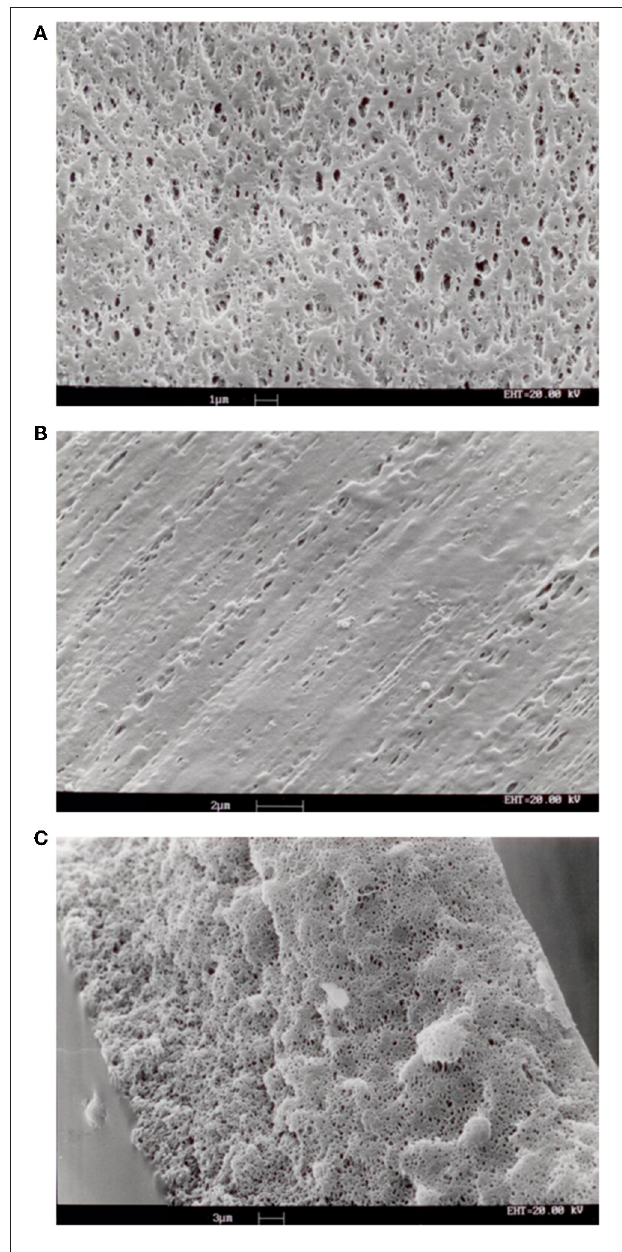
FIGURE 3 | SEM images of samples of membranes Type I: (A) inner surface; (B) outer surface; (C) cross-section of membrane wall.